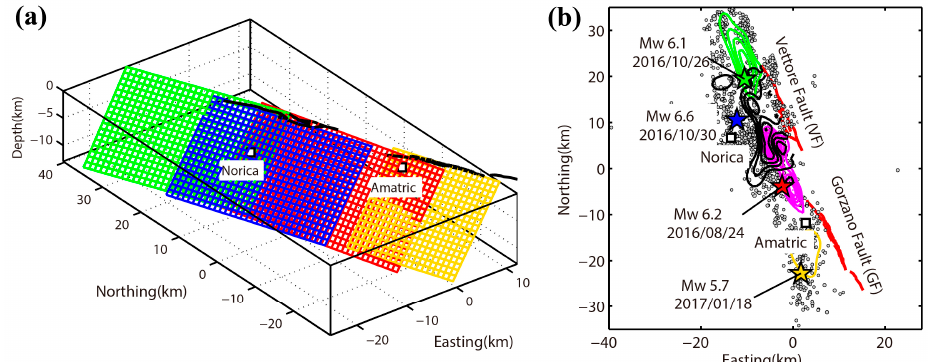
Figure 11. ( a ) Three-dimensional views of the fault models of the 2016–2017 Central Italy earthquake sequence (red for the 2016 Amatrice earthquake, green for the 2016 Visso earthquake, blue for the 2016 Norcia earthquake and golden yellow for the 2017 Campotosto earthquake); ( b ) The coseismic rupture region of the four main events of the 2016–2017 Central Italy earthquake sequence. The purple contours represent the coseismic rupture regions (slip ≥ 0.2 m) of the 2016 Amatrice earthquake. The green contours display the coseismic rupture region (slip ≥ 0.2 m) of Visso earthquake. The blue contours show the coseismic rupture region (slip ≥ 0.5 m) of Visso earthquake. The golden yellow contour denotes the coseismic rupture region (slip ≥ 0.2 m) of 2017 Campotosto earthquake. The stars and gray dots show the main shock and large aftershocks (ML ≥ 3) of the 2016–2017 Central Italy earthquake sequence.